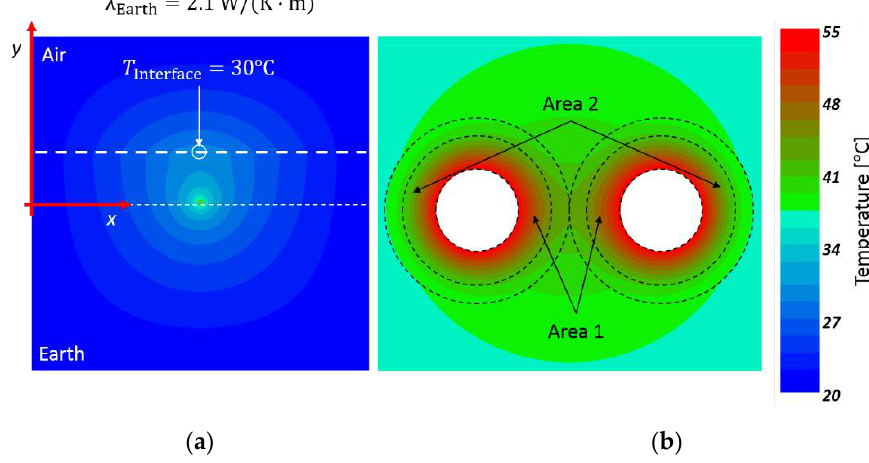
Figure 13. ( a ) Temperature distribution around a MI cable pair, with a soil thermal conductivity of 2.1 W / (K · m) and T ∞ = 20 ◦ C; ( b ) temperature distribution within the insulation